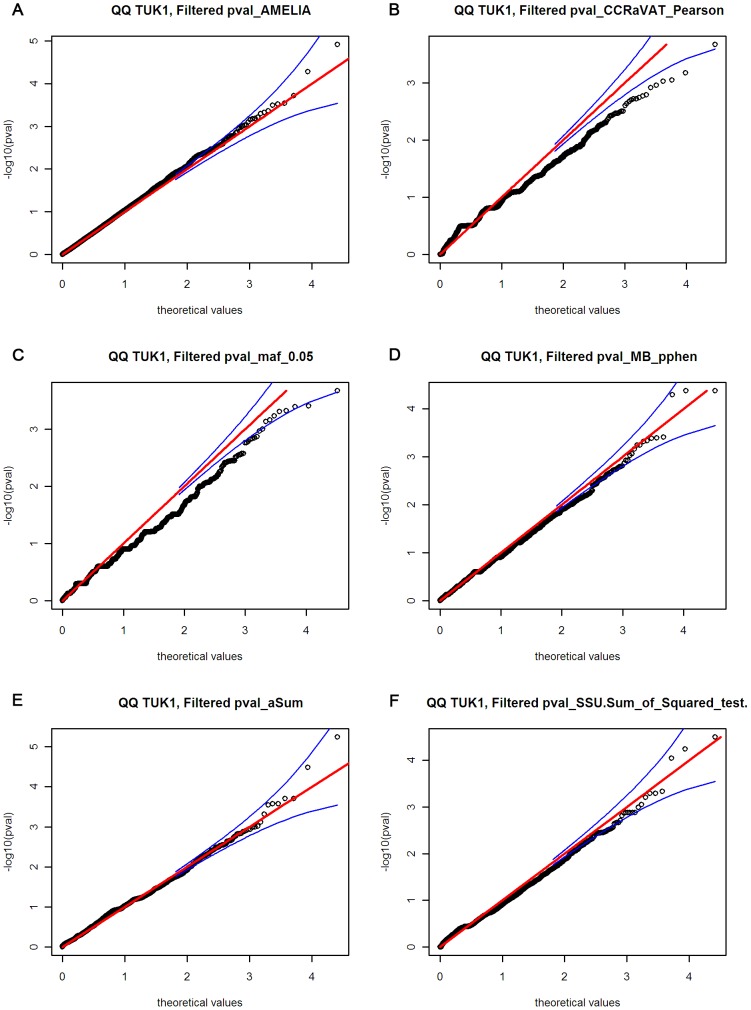
Quantile–quantile plots for the six different variant burden analysis methods.Quantile–quantile plots are shown for: (a) AMELIA, (b) CCRaVAT, (c) fixed filter test, minor allele frequency <0.05, (d) Madsen-Browning with polyphen weights, (e) Han and Pan aSumtest, (f) SSU, sum-of-squares test (Han and Pan).